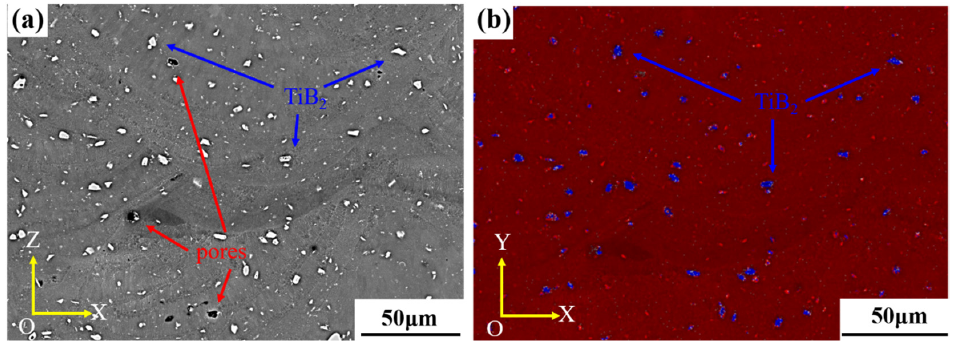
Figure 4. The microstructure of as-printed TiB 2 /AlZnMgCu(Sc,Zr) composite samples: ( a ) SEM and ( b ) EDS planar scanning.